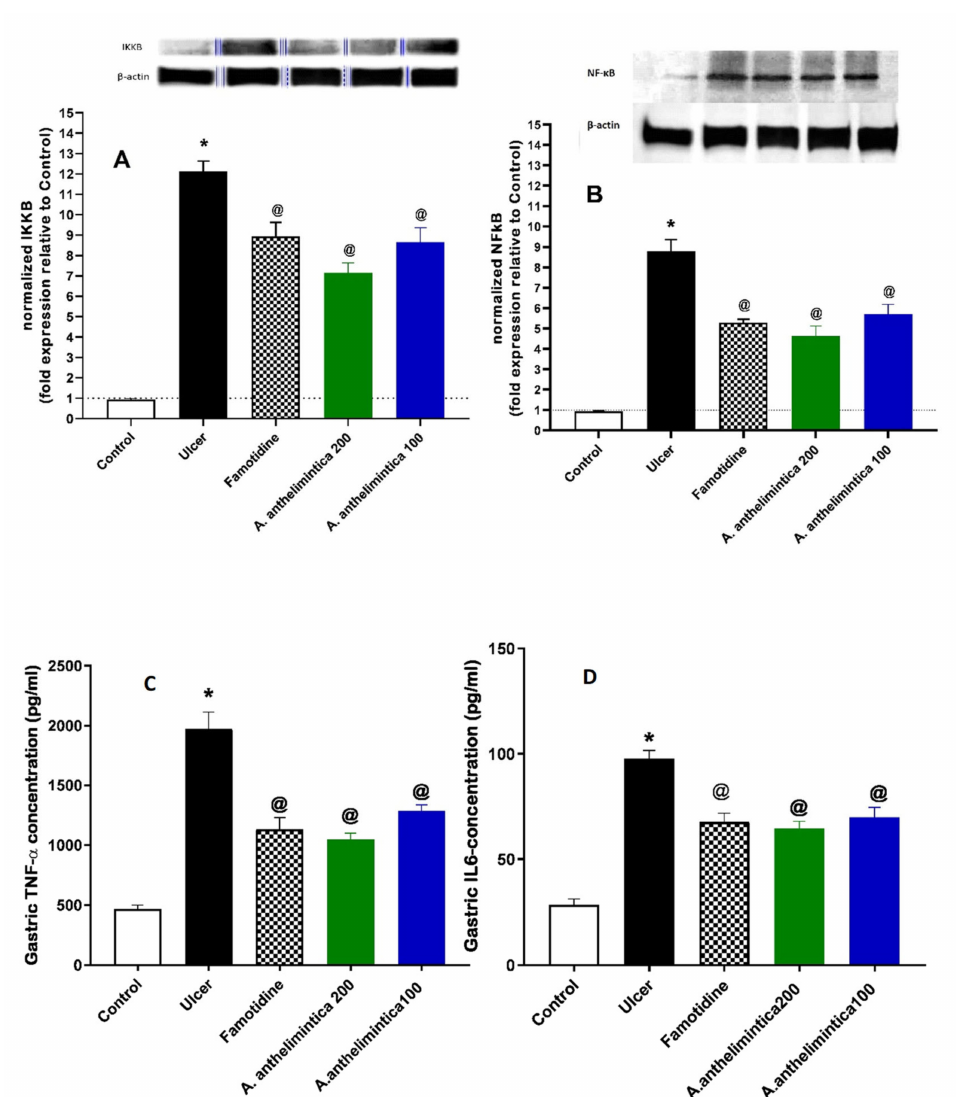
Figure 7. Effects of indomethacin alone and with oral pre-treatments of famotidine or A. anthelmintica (200, 100 mg/kg) on ( A ) gastric inhibitor of nuclear factor kappa-B kinase subunit beta (IKKB), ( B ) gastric nuclear factor KB (NF- κ B), ( C ) gastric TNF- α , and ( D ) gastric IL-6 in rats. Statistical analyses were carried out by one-way ANOVA followed by Tukey’s post hoc test, mean ± SEM. * Significantly different from control group at p < 0.05. @ Significantly different from indomethacin alone group at p <